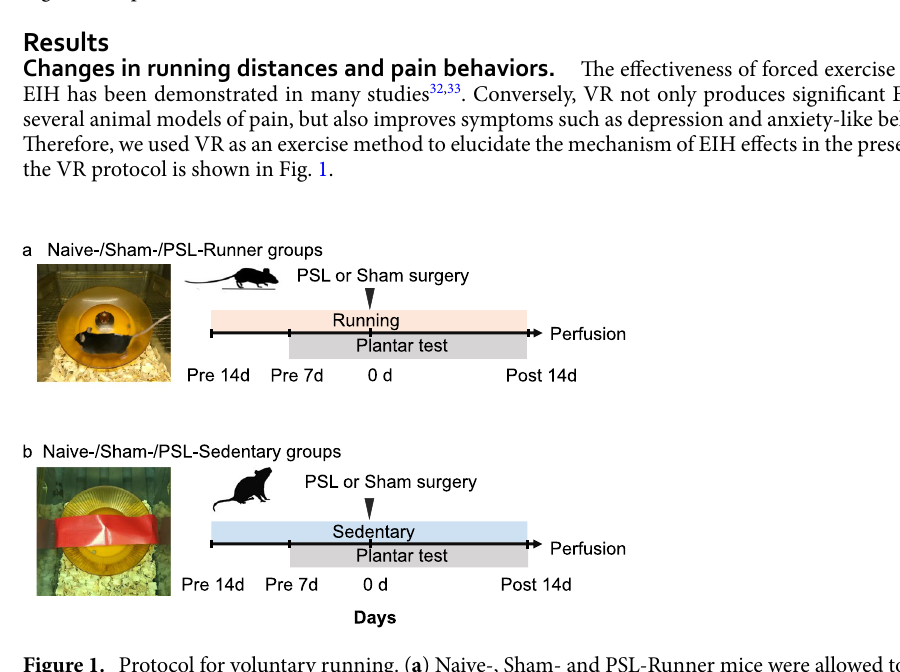
Figure 1. Protocol for voluntary running. ( a ) Naive-, Sham- and PSL-Runner mice were allowed to run freely on the running wheel, whereas ( b ) Naive-, Sham- and PSL-Sedentary mice were reared in cages with a locked running wheel. Mice in all experimental groups were placed in individual cages. PSL partial sciatic nerve